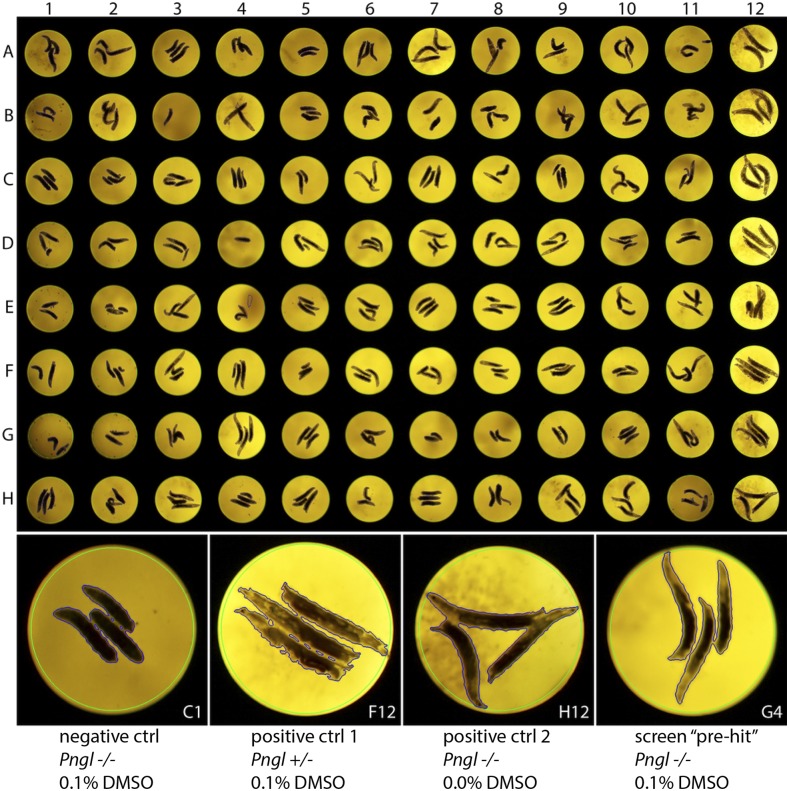
Layout of an PnglPL assay plate with examples of controls and pre-hit compound. Larvae were cultured in 96-well plates with negative controls on the left most wells (column 1) which carried PnglPL homozygous with vehicle DMSO at 0.1%. 80 testing wells were in the middle (columns 2-11) which carried PnglPL homozygous larvae with a compound at 1μM, and DMSO at 0.1%. Right most top wells (12A-12F) contain positive control group 1 with PnglPL heterozygous larvae and 0.1% DMSO. Right most bottom wells (12G-12H) contain positive control group 2 with PnglPL homozygous larvae without DMSO. The compound in well G4 was considered a pre-hit compound.